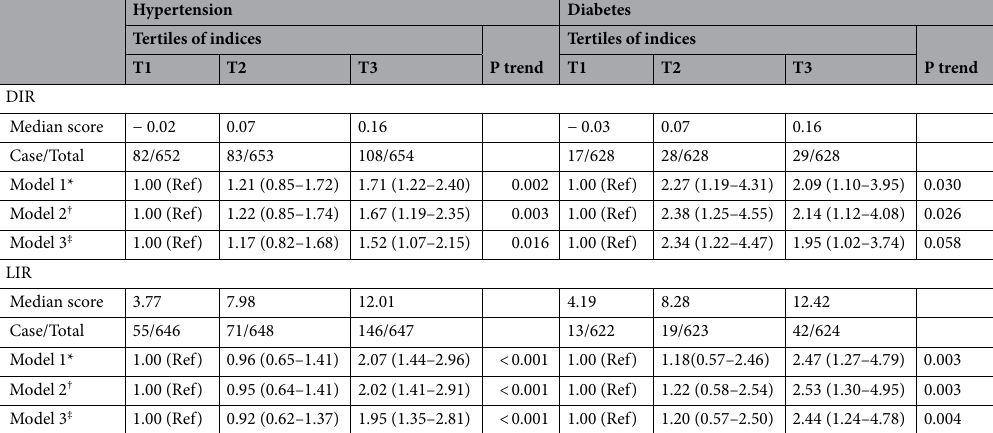
Table 4. The association between the insulinemic dietary and lifestyle indices with the incidence of hypertension and diabetes: the Tehran Lipid and Glucose Study. *Model 1: adjusted for age and sex. † Model 2: adjusted for model 1 and energy intake, smoking, education level, occupation status, and physical activity (only for DIR). ‡ Model 3: adjusted for model 2 and baseline VAI (for DIR) and TG to HDL-c ratio and waist residual BMI (for